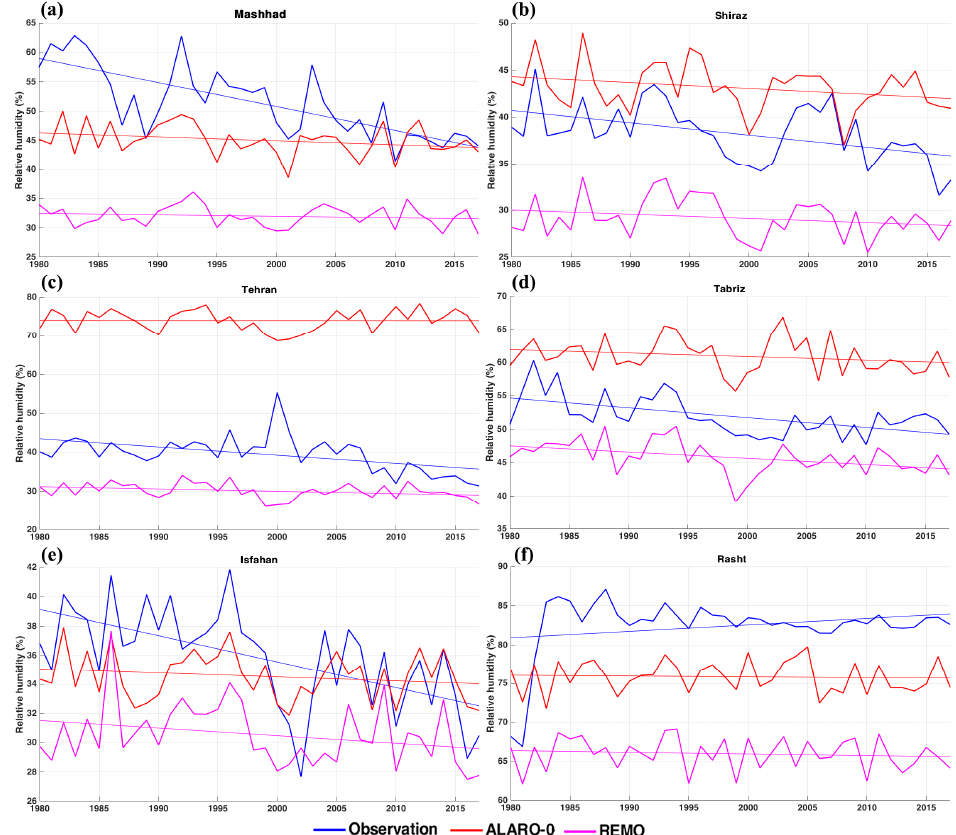
Figure 10. Annual average relative humidity for studied stations, comparing models with observations over the studied stations: Mashhad ( a ), Shiraz ( b ), Tehran ( c ), Tabriz ( d ), Isfahan ( e ) and Rasht ( f ) during 1980–2017.